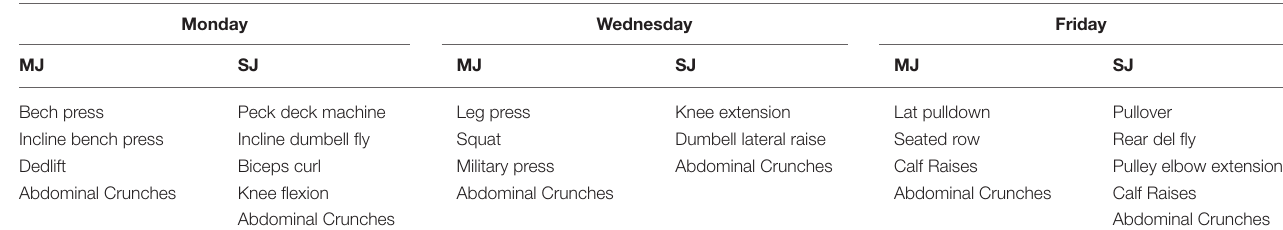
TABLE 1 | Training programs for the multi-joint (MJ) and single joint (SJ)